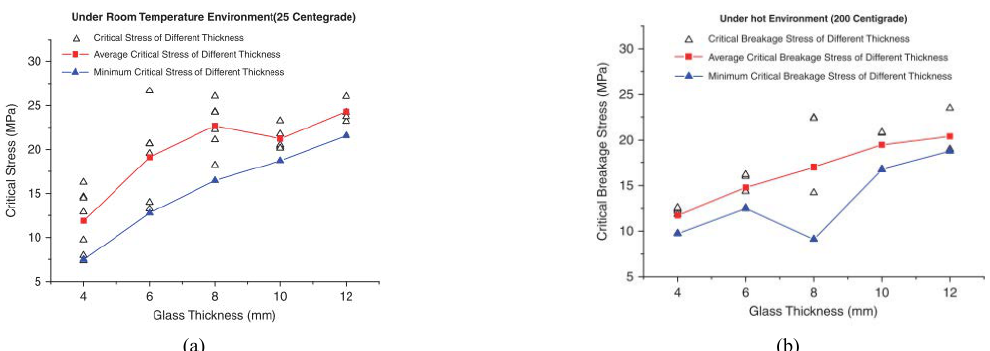
Fig. 6 AN SLS glass: Temperature dependence of critical breaking stress for different thicknesses (Xie et al.